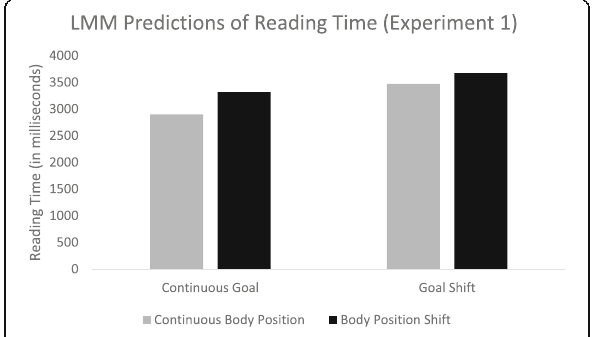
Fig. 6 Predicted reading times for experiment 1 from linear mixed effects model by condition. LMM, linear mixed model